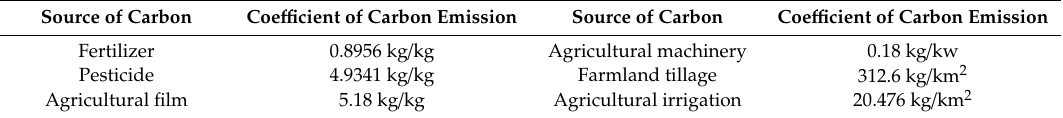
Table 2. The coe ffi cient of carbon emission of major sources of carbon in cultivated land use.